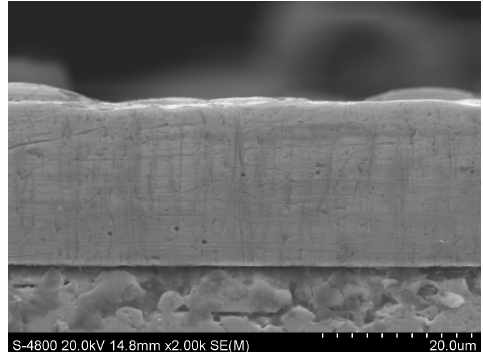
Figure 7. The cross section of the 20% laser energy density coating.